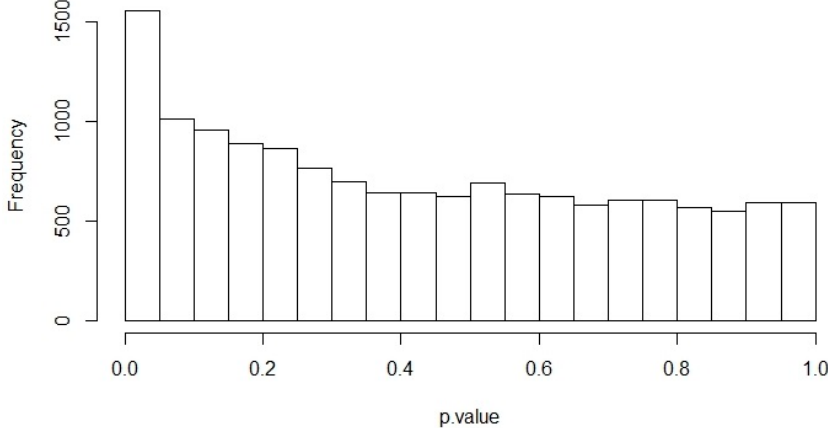
Figure 1. Correlation analysis between ACE2 expression level and 14,700 genes in the 58 normal lung samples. Distribution of p -values from Pearson’s Correlation test.